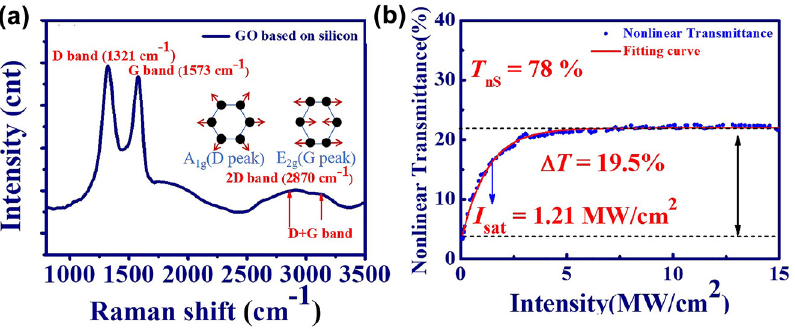
Figure 1: Characterization of GO/PVA film. (a) Raman spectrum of the GO platelet. (b) Nonlinear transmittance of the GO/PVA film (blue circle) and the theoretical fitting curve (red solid line) by the nonlinear transmittance.